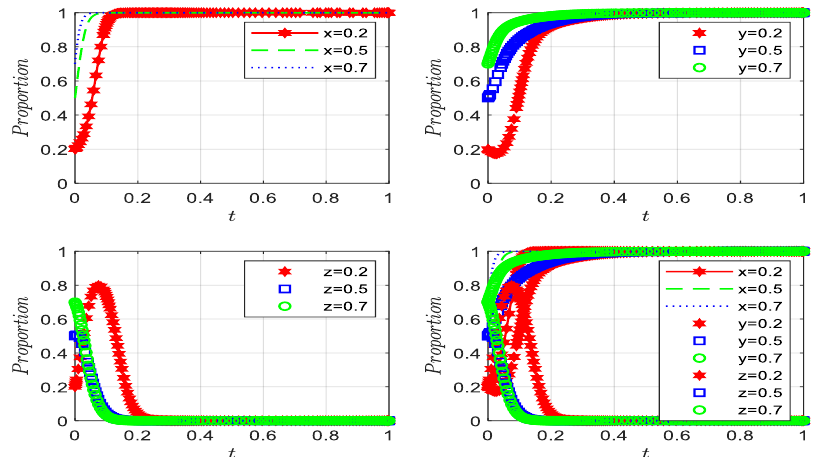
Figure 14. The influence of initial values of three agents on evolutionary processes.